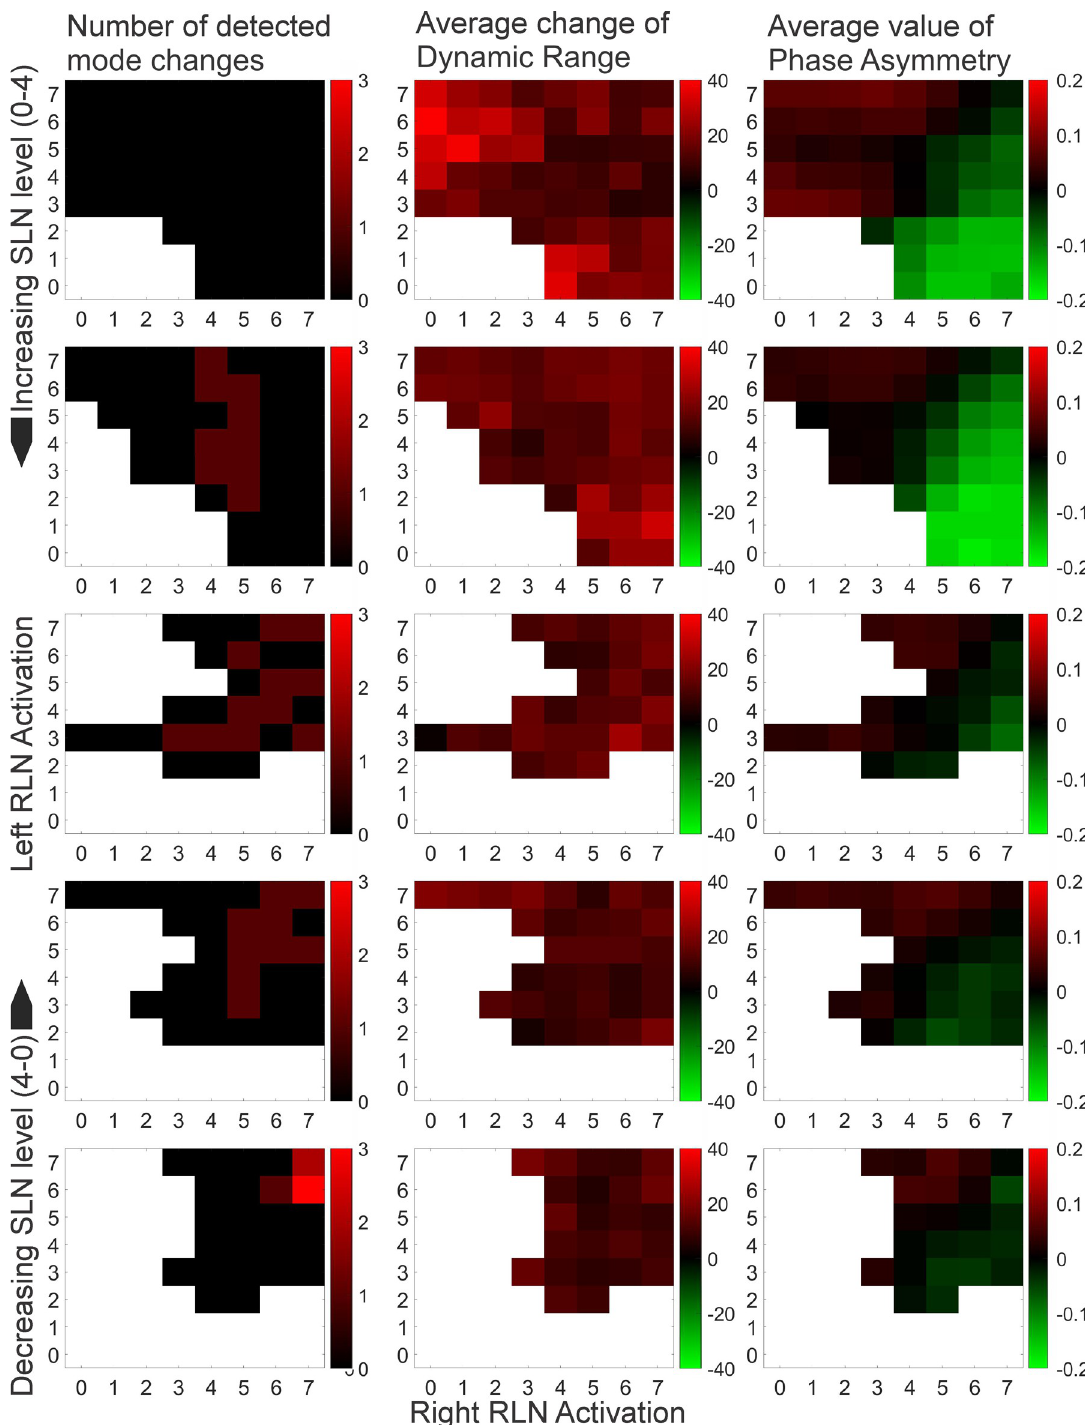
Fig 2. Detected mode changes, change of DR and symmetry relative to SLN and RLN activation. Blank (white) data points reflect neuromuscular conditions where phonation onset did not occur. In the first column red shades reflect the number of detected mode changes; in the second column red shades reflect an increase in dynamic range over time; in the third column red shades reflect a left sided phase lead and green shades a right sided one.